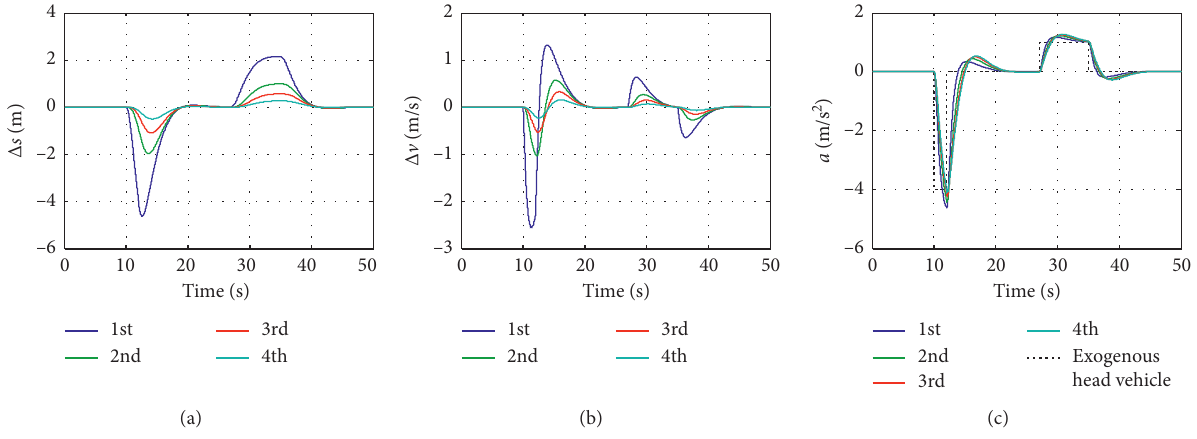
Figure 5: Simulation result of CSG: (a) gap error, (b) relative speed, and (c) actual acceleration.